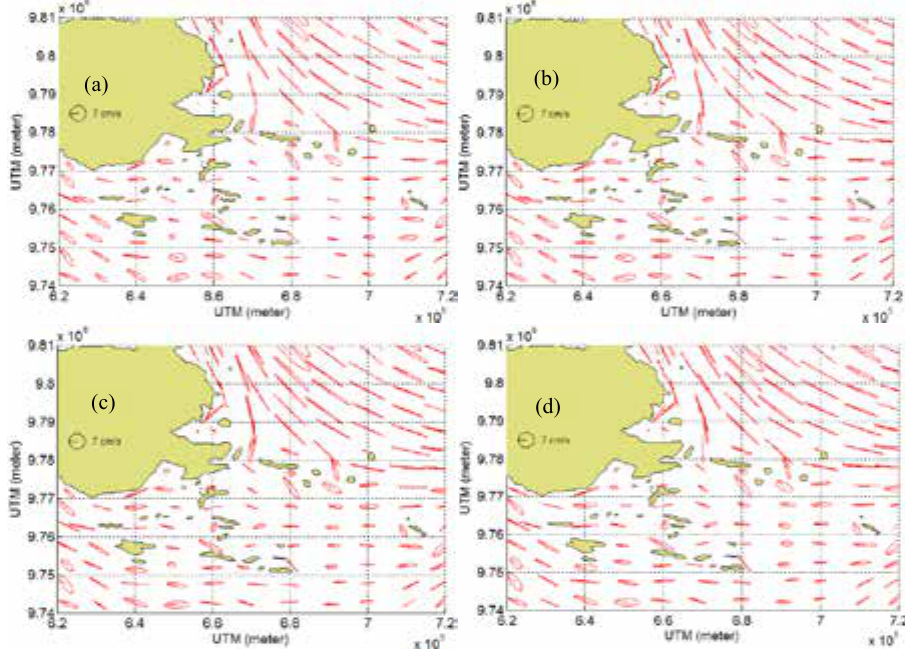
Fig. 8: The calculated O1 tidal current in layer-1 near the bottom (a), layer-4 of water column (b), layer-7 of water column (c), and layer-10 at the surface water (d)